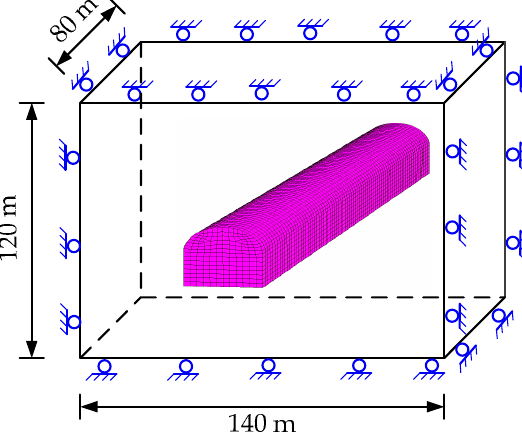
Figure 4. Three-dimensional numerical model. Table 1. Mechanical parameters of surrounding rock.